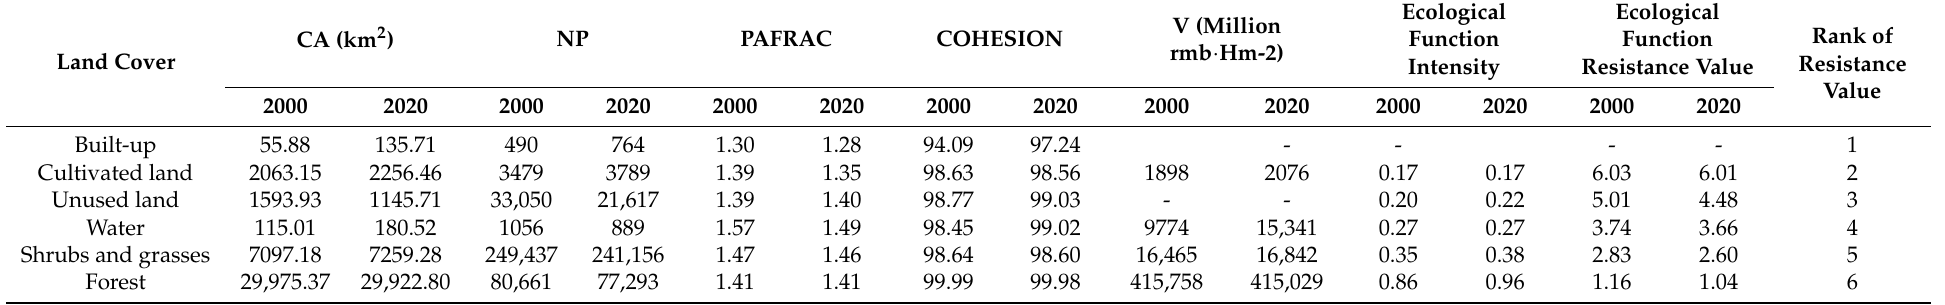
Table 3. Landscape pattern indices, ecological function intensities, and resistance values in 2000 and